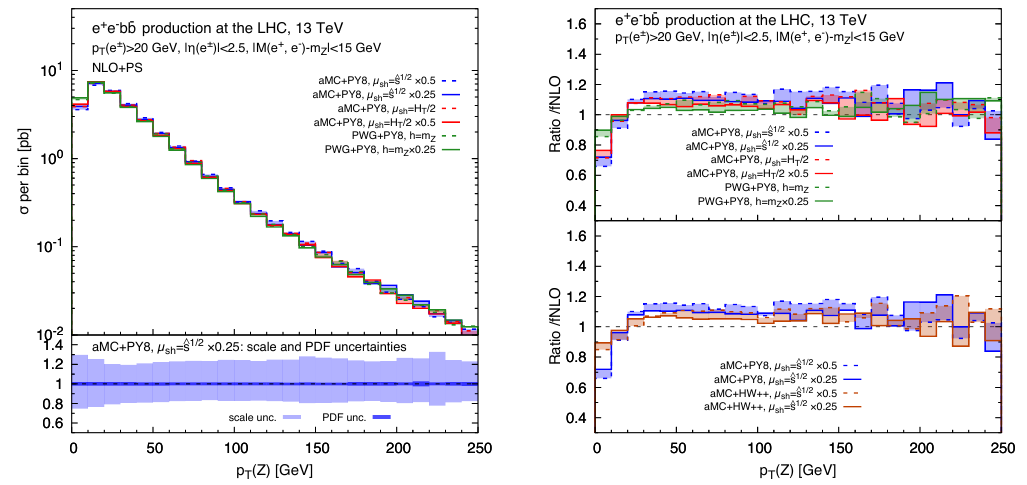
Figure 7 . p ‘ + ‘ (cid:0) distribution in the 4FS inclusive over the b -quark contribution. Same approxi- ? mations and colour codes as in (cid:12)gure